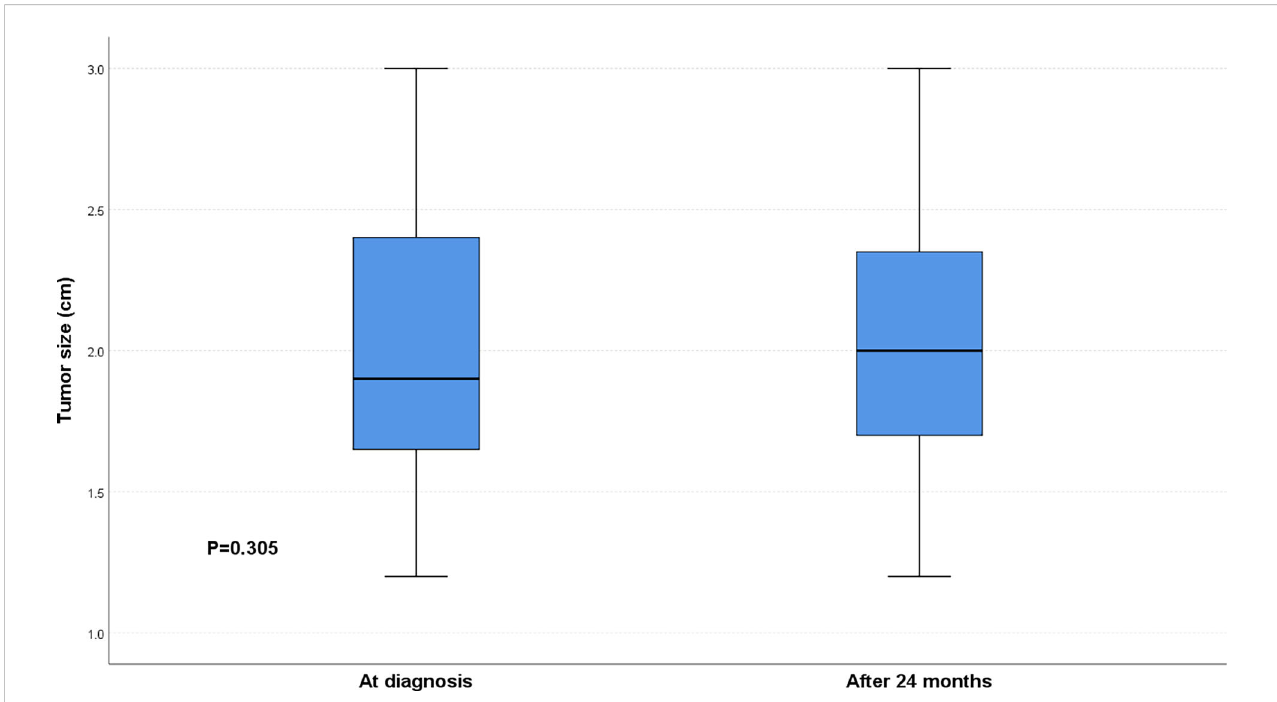
FIGURE 2 Comparison of tumor size at diagnosis and 24 months later in the conservative treatment group. Within 24 months, patients in the conservative treatment group showed no signi fi cant tumor